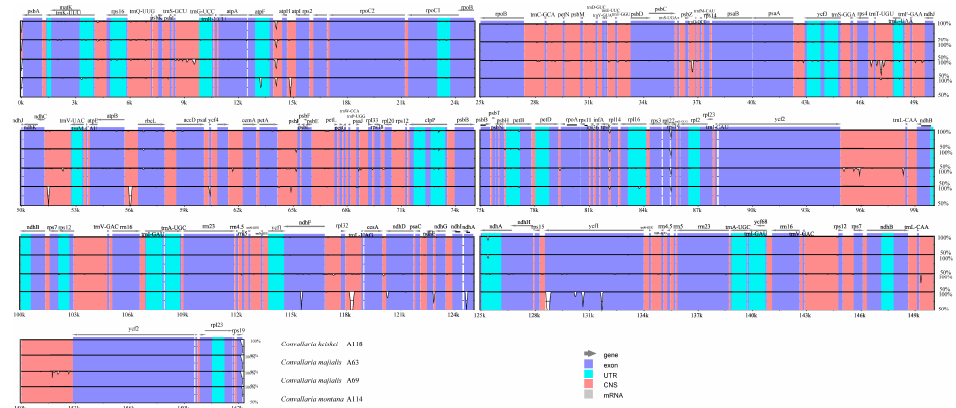
Figure 3. Sequence identity plots among five Convallaria chloroplast genomes, with S. keiskei as a reference. CNS: conserved non-coding sequences; UTR: untranslated